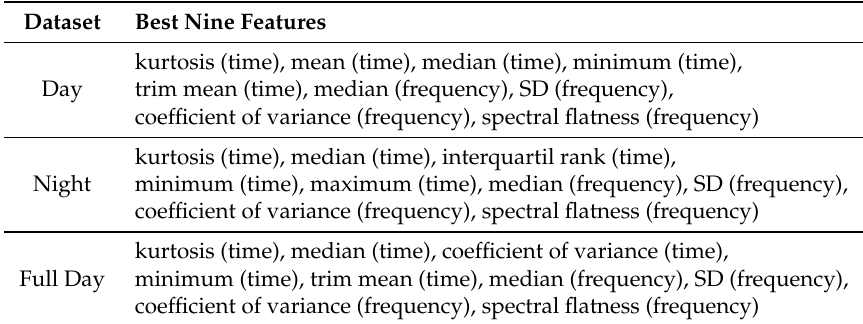
Table 5. Best nine features model in every dataset; day, night and full